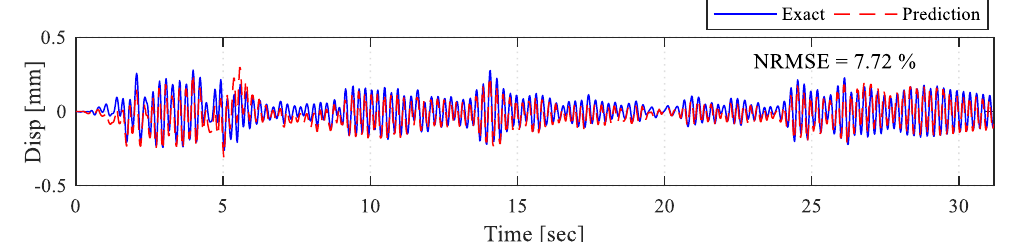
Figure 21. LSTM-predicted brace displacement input from Model 1a RTHS test with specimen but based on actual feedback as compared to the exact analytical solution.